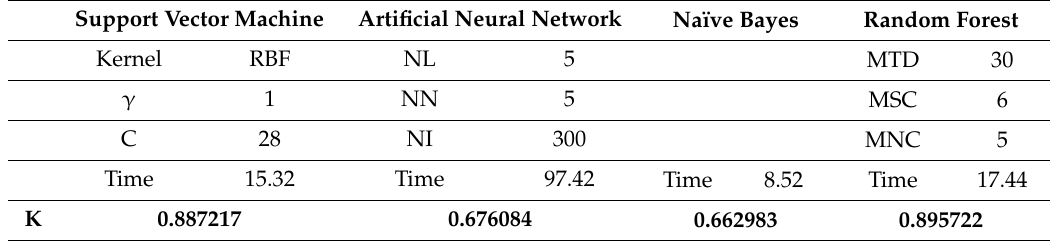
Table 14. Overall performance with the best combination of each model for Osijek. Support Vector Machine Artificial Neural Network Naïve Bayes Random Forest